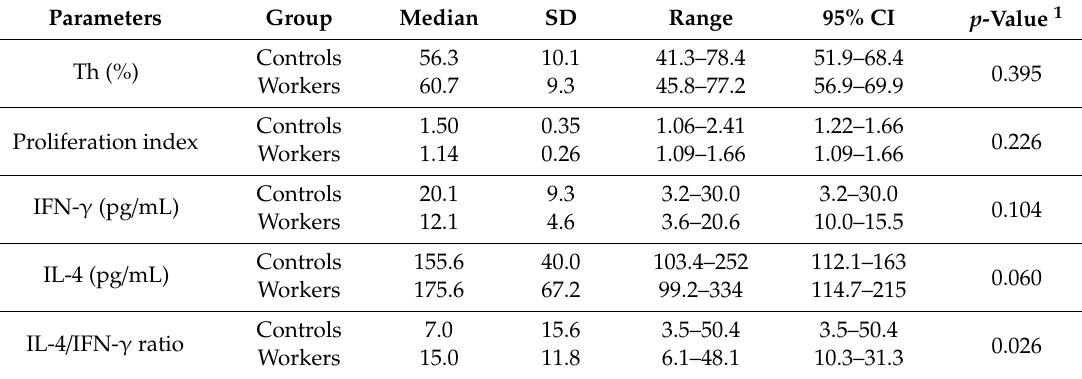
Table 2. Profiling of immunologic